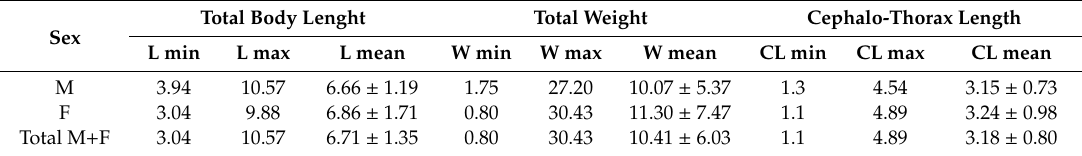
Table 2. Body size measures. Distribution range (minimum, maximum, mean, and standard deviation values) for the main biometric features for Orconectes limosus . Wtot: n = 227, Ltot and Lcft: n = 238.